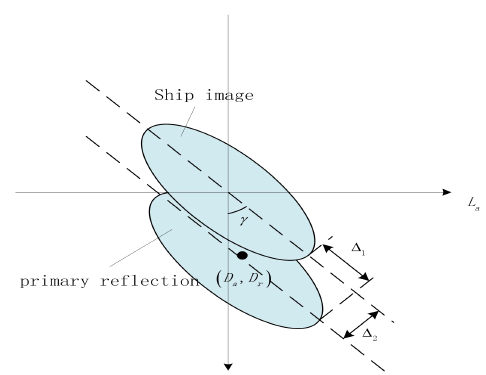
Figure 3.Simplified model of ship image and its primary artifacts